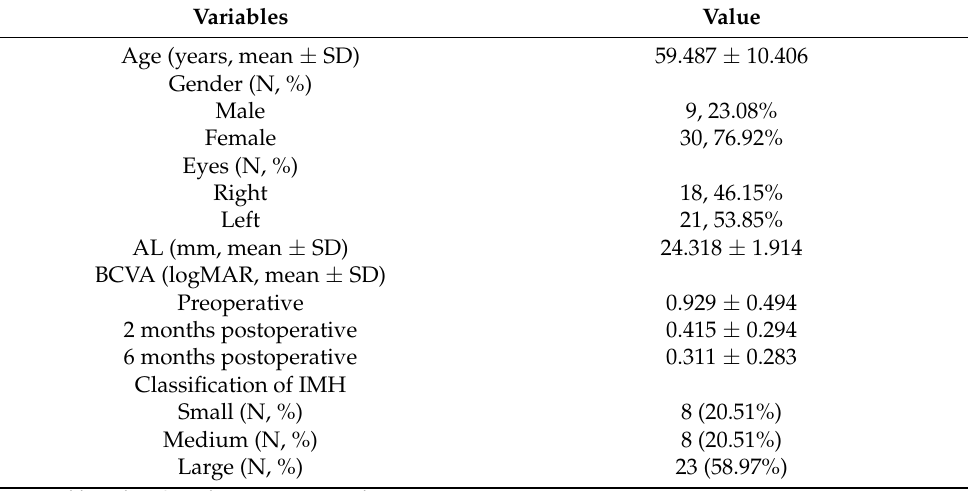
Table 1. Demographics and clinical characteristics of study subjects (n =